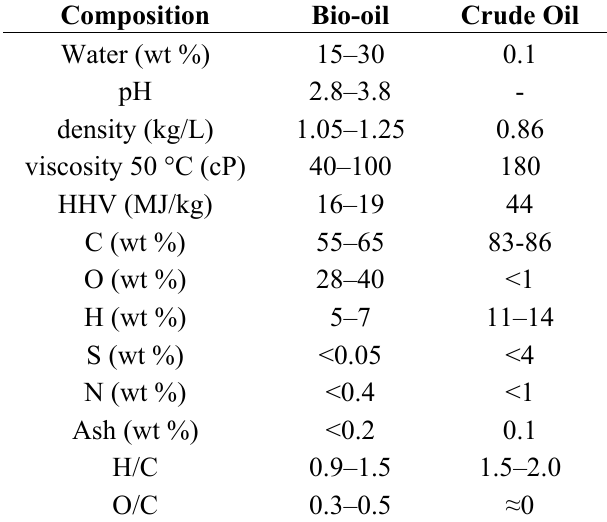
Table 1. Bio-oil vs. crude oil